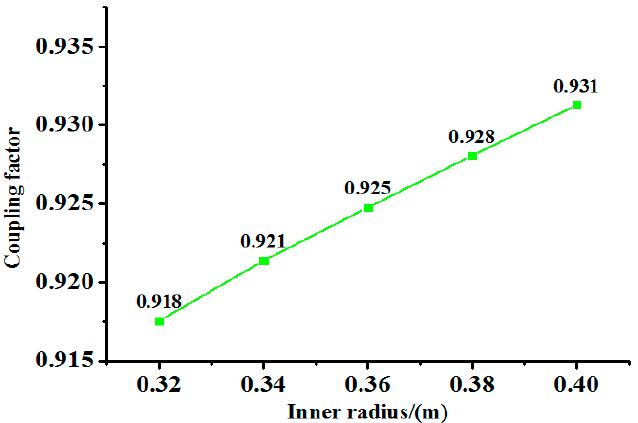
Figure 11. The curve between the inner radius and coupling factor (encapsulation height = 1.2 m).